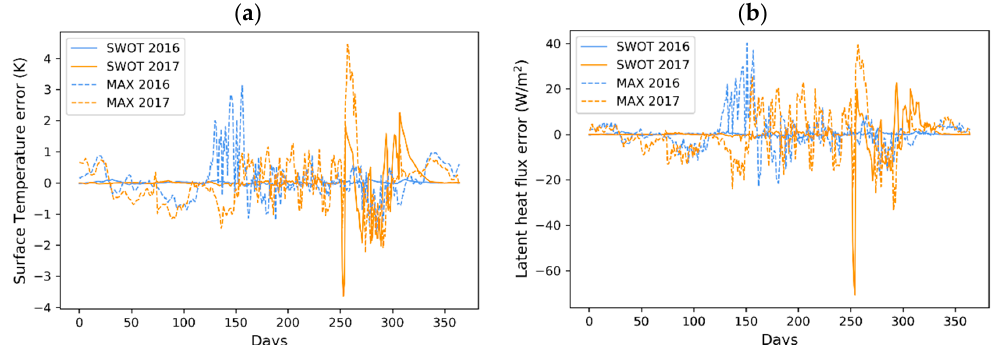
Figure 9. Temporal evolution of the surface temperature ( a ) and latent heat flux ( b ) errors, respectively, in K and W/m 2 , calculated for the T6G2 gravel pit and for the two years 2016 and 2017. The two depth scenarios SWOT and MAX are compared to REF. Table 4. Standard (Std) and maximum (max) errors on FLake surface temperature (in K) and surface heat fluxes (in W/m 2 ), calculated over a five-year period, for the four reservoirs of the Seine and T6G2 gravel pit. The comparison is done for the MAX and SWOT simulations in comparison to REF.